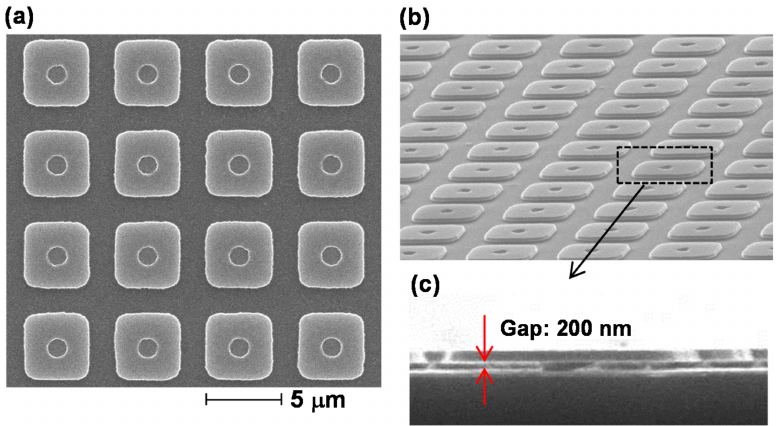
Figure 12. SEM images of MR-PMAs with tubular posts: ( a ) top; ( b ) oblique; and ( c ) magnified cross-sectional views of the periodic structures.